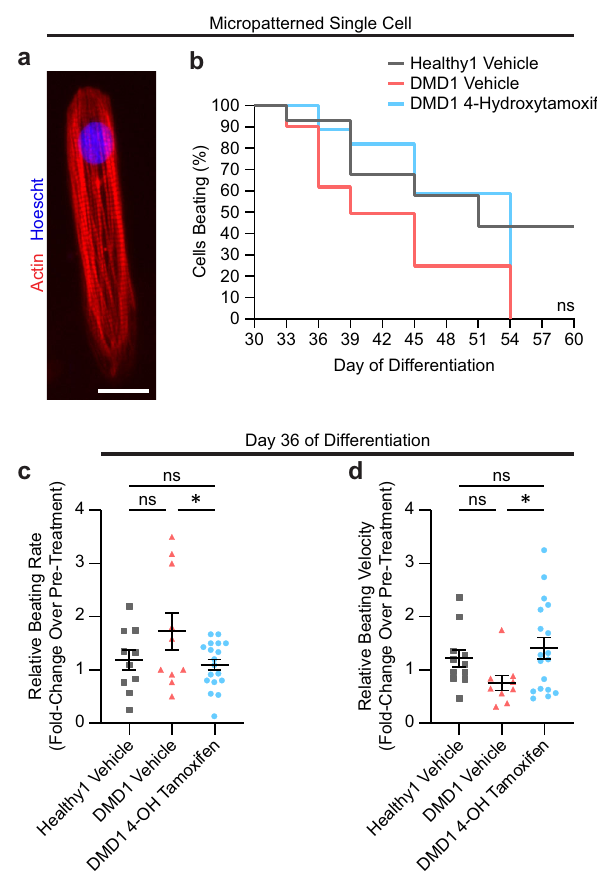
Fig. 5 Treatment with 4-hydroxytamoxifen prolongs cell survival, decreases beating rate, and increases beating velocity in micropatterned single cells. a Micrograph of a patterned iPSC-CM stained with F-actin (red) and Hoescht (blue) taken at ×40 magni fi cation. Scale bar represents 20 μ m. b Percentage of iPSC- CMs that retained the ability to spontaneous beat as individual cells. n = 3 biological replicates, N = 14 – 29 cells. Statistical signi fi cance determined by log-rank (Mantel – Cox) test with Bonferroni correc- tion. c , d Relative beating rate and relative beating velocity on day 36 of differentiation represented as fold change over pre-treatment (day 30) to chronic 0.5 μ M 4-hydroxytamoxifen or vehicle. Cells were treated every 3 days beginning on Day 30. Data represent mean ± SEM. Statistical signi fi cance determined by one-way ANOVA and Tukey test for post hoc comparison. * P < 0.05, ns (nonsigni fi cant). n = 3 biological replicates, N = 9 – 18